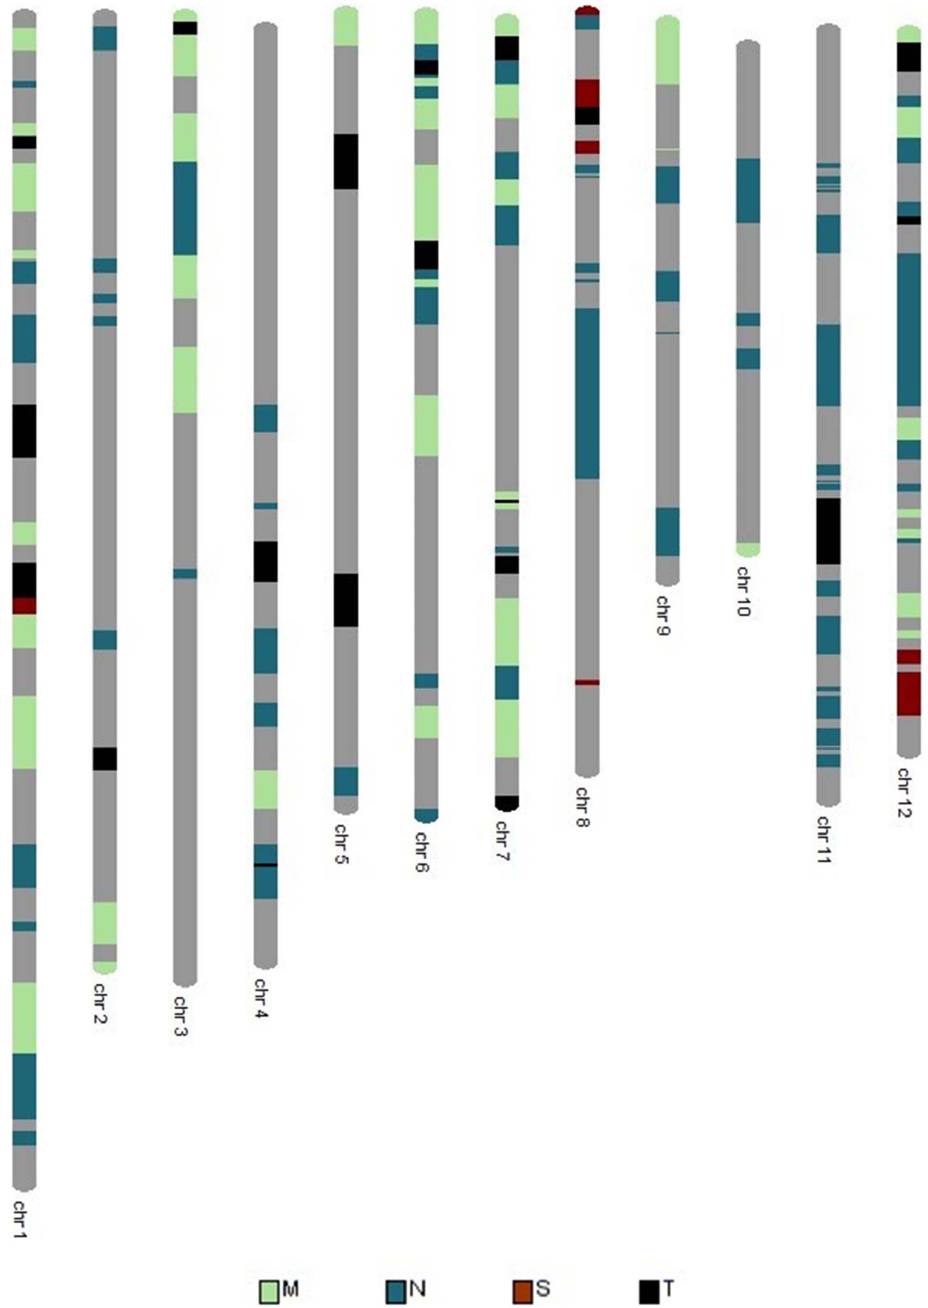
Figure 2. Physical map of markers showing segregation distortion, known genes for disease resistance in rice, and QTLs reported for blast resistance in the Moroberekan/CO39 population. M = markers showing distortion in favour of Moroberekan, S = markers showing distortion in favour of Swarna, N = genes coding for NBS-LRR proteins, and T = QTLs reported for blast resistance in the Moroberekan/CO39